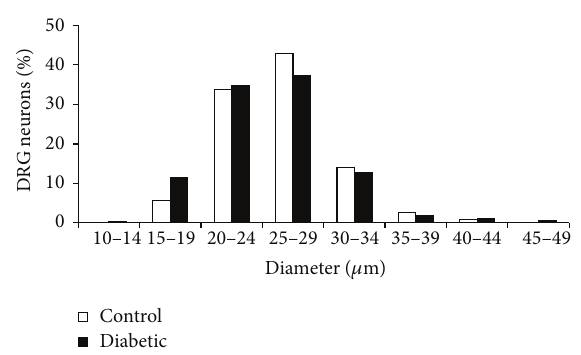
Figure 1: Distribution of neuronal cell diameter. The neurons were divided into 5 𝜇 m bins. Small-diameter neurons had diameters < 30 𝜇 m, medium-sized neurons had diameters between 30–39 𝜇 m, and large-diameter neurons had diameters of ≥ 40 𝜇 m. The majority of tested neurons were small-sized. n (control) = 552, n (diabetic) =